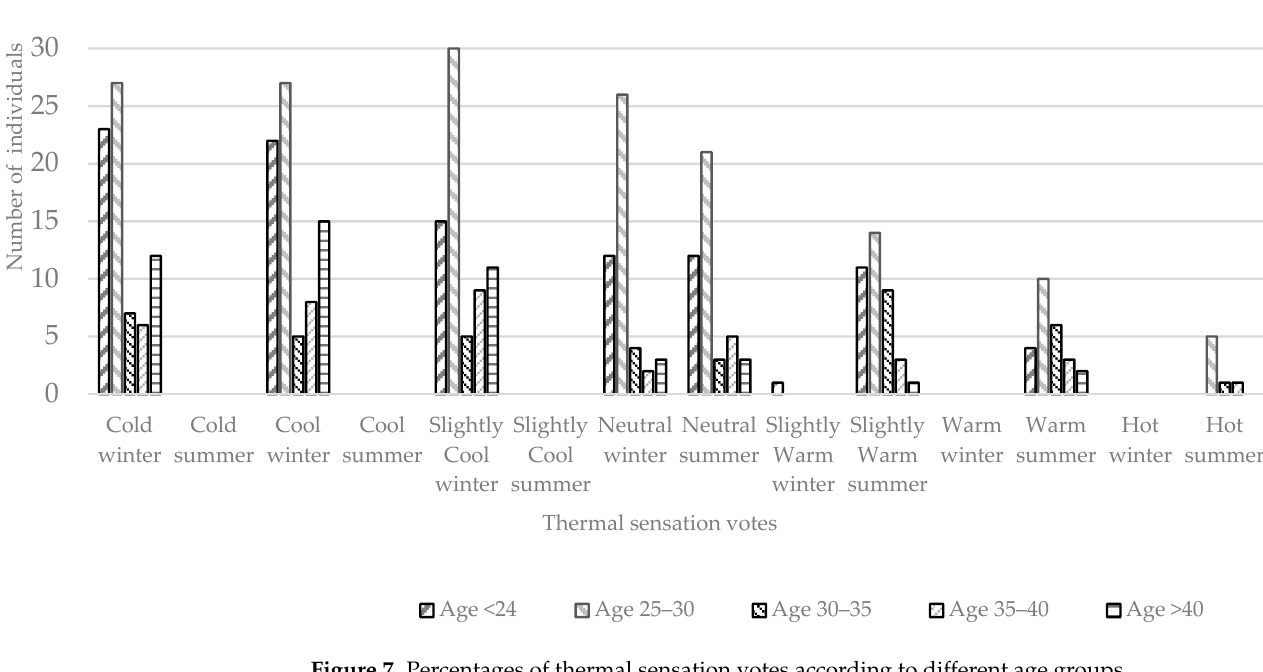
Figure 7. Percentages of thermal sensation votes according to different age groups.